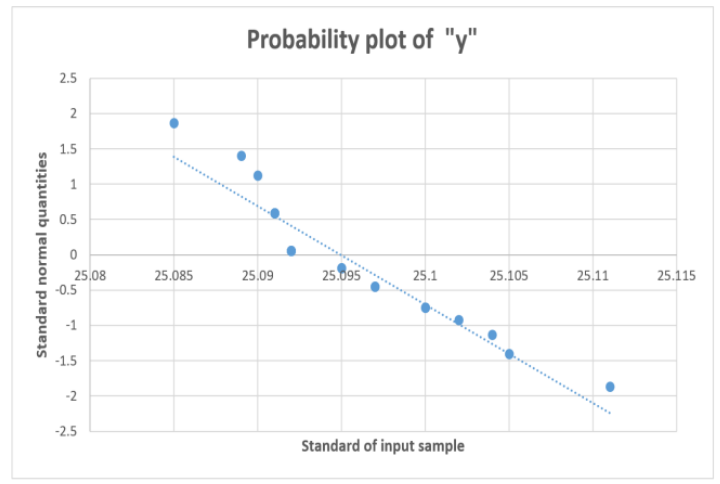
12 of 16 Figure 9. Normality test for “ x ” axis of sensing object.